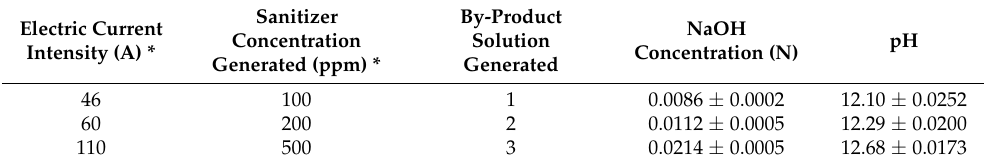
Table 2. Proximate analysis of the commercial soybean flour. Component This Study (%) Reported Values (%) [44] Fiber 4.28 ± 0.10 Fat Protein Ash Carbohydrate * Moisture